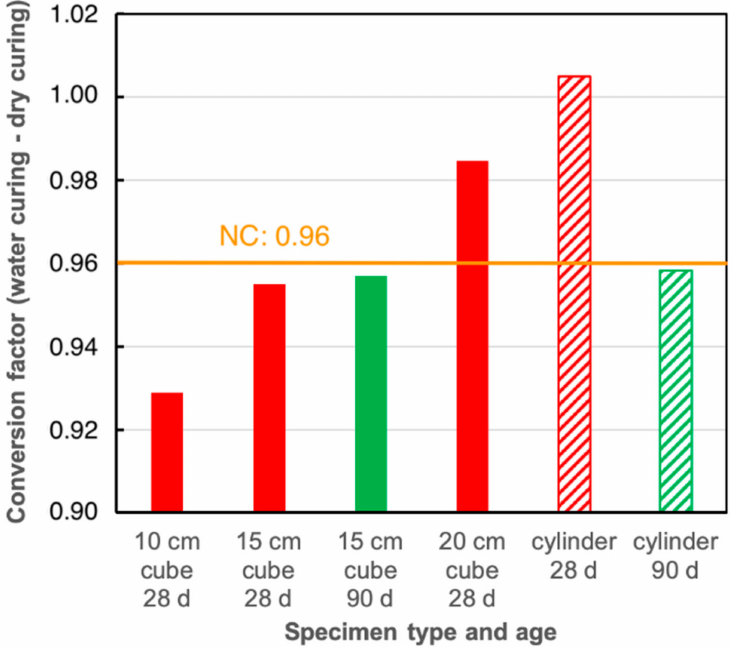
Figure 7. Conversion factors between specimens cured under water [116] or in a climate room (20 ◦ C / 65% relative humidity) following the German national annex to [116] for di ff erent specimens sizes, shapes and testing ages